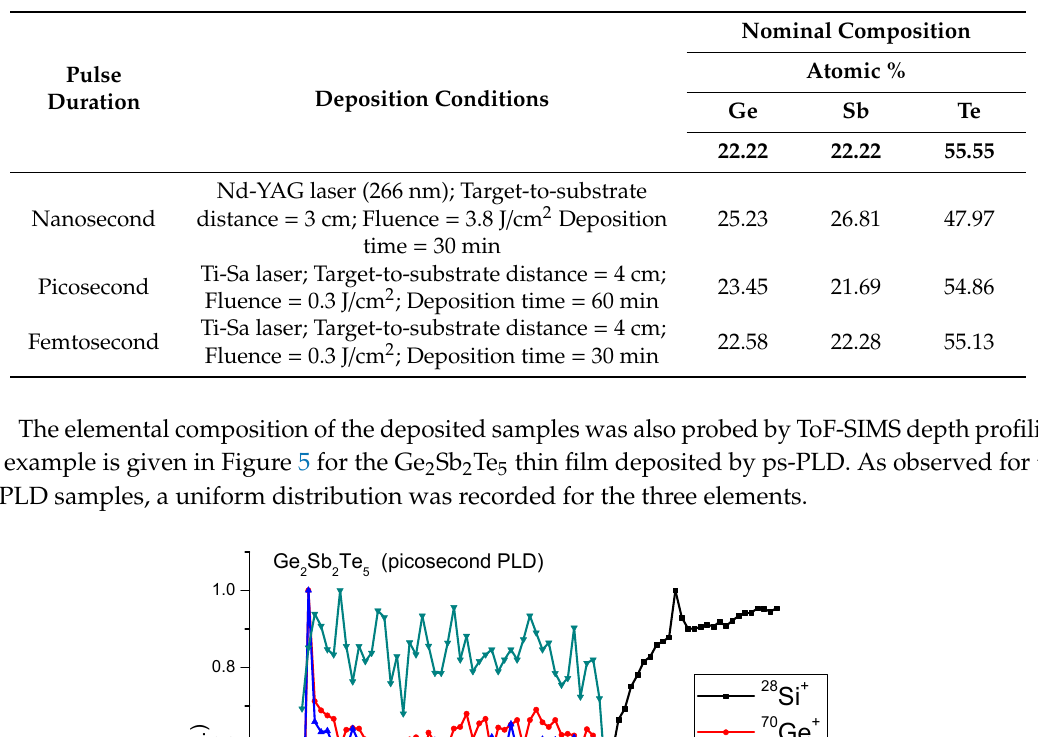
(b) Figure 6. Raman spectra of the ( a ) GeTe and ( b ) Ge 2 Sb 2 Te 5 thin films deposited in different conditions by fs-PLD.